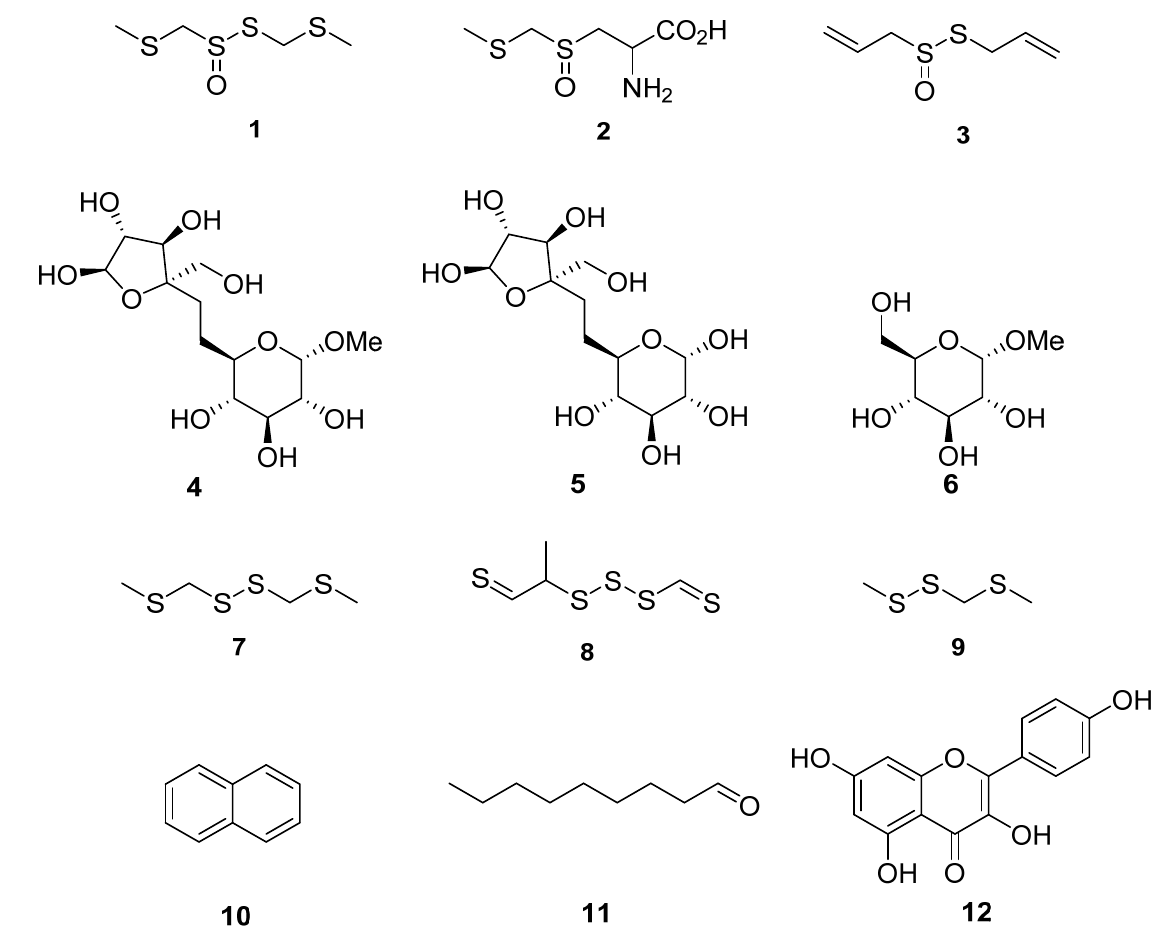
Figure 3. Chemical structures of compounds identified in T. violacea . (1) Marasmicin ( 1 ), (2) maras-